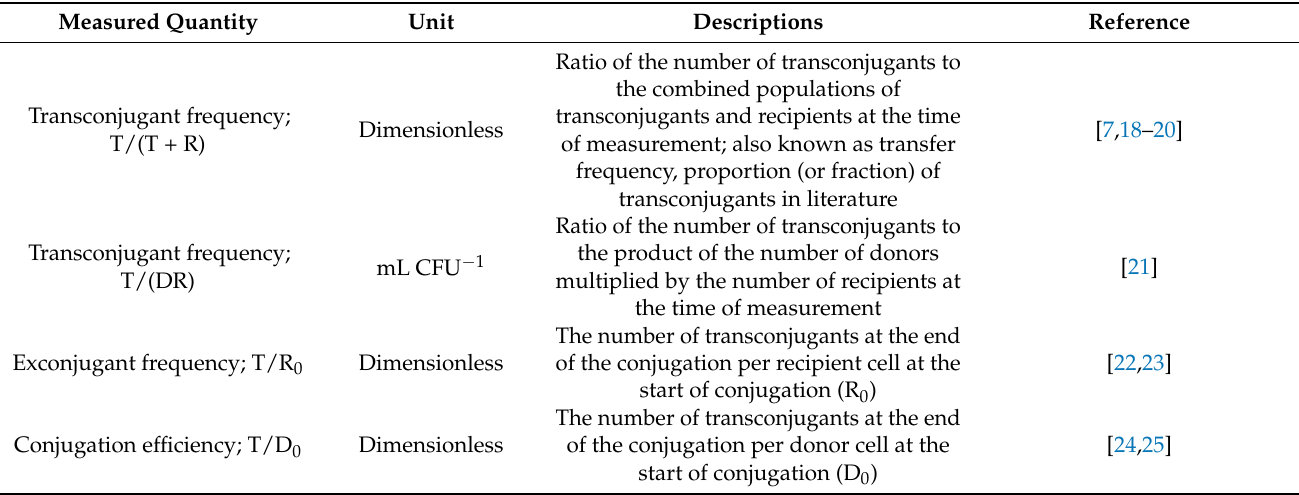
Table 1. Measured quantities in commonly used methods for characterizing frequencies at which conjugative plasmids are transferred from donors (D) to recipients (R) to form transconjugants (T) during bacterial